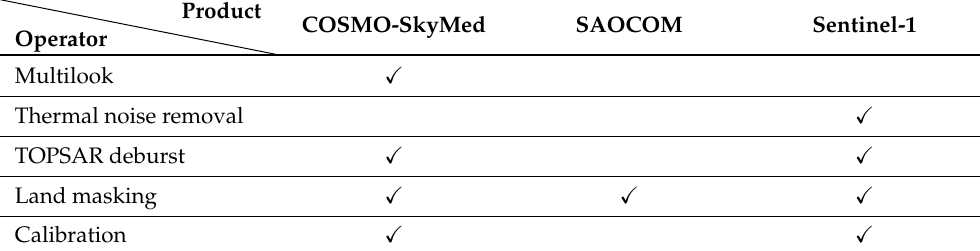
Table 3. Pre-processing operators used for each SAR